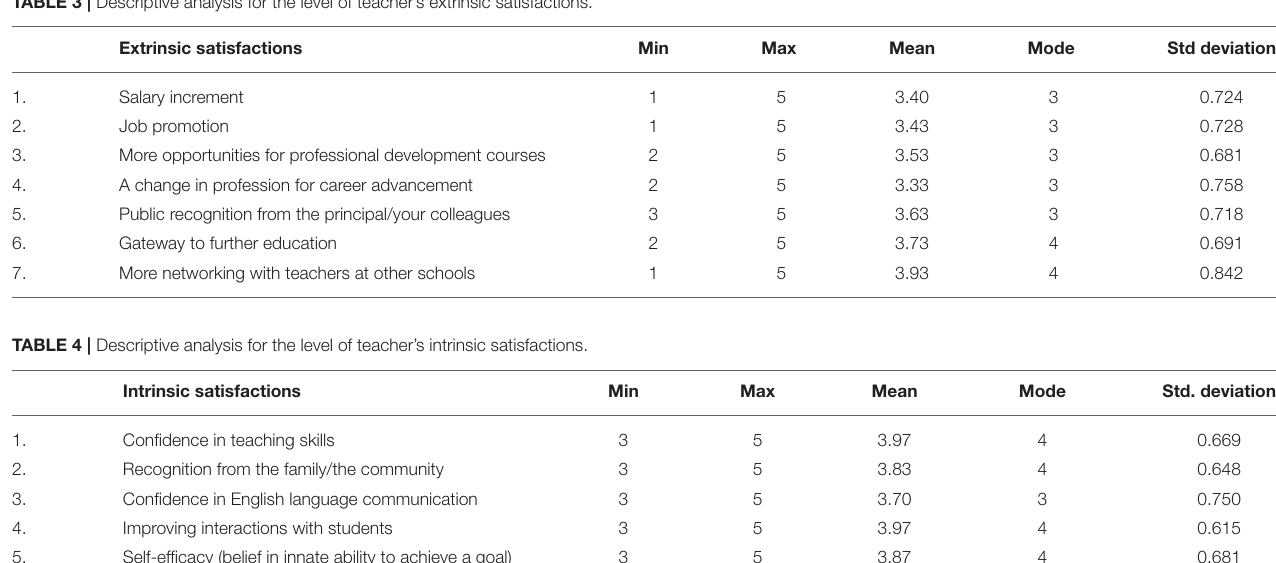
TABLE 3 | Descriptive analysis for the level of teacher’s extrinsic satisfactions.